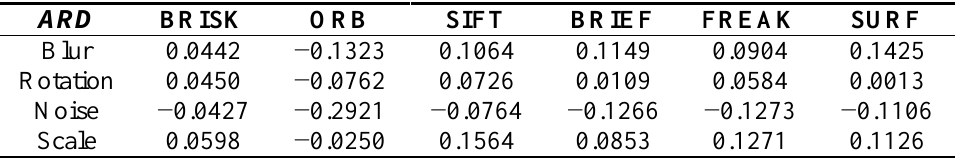
Table 2. Average Recall Difference for the algorithms evaluated with the framework presented in Section 3 (bold values correspond to the algorithm that has the best relative performance in LWIR for the tested